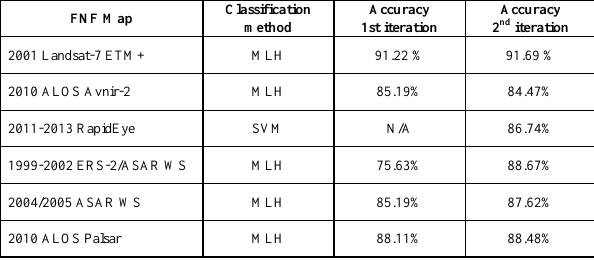
Table 1: FNF product accuracy in percent.